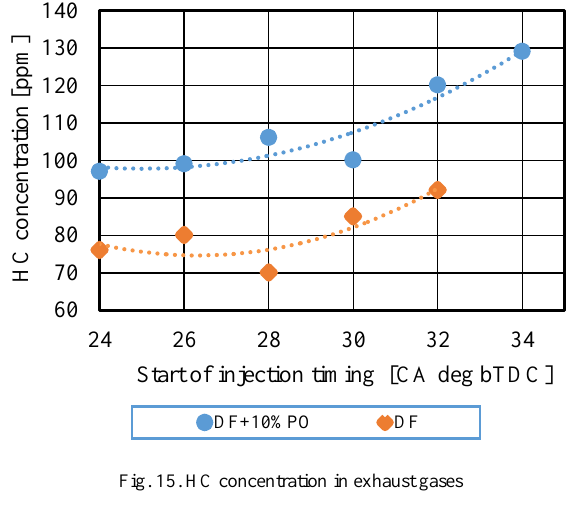
Fig. 15. HC concentration in exhaust